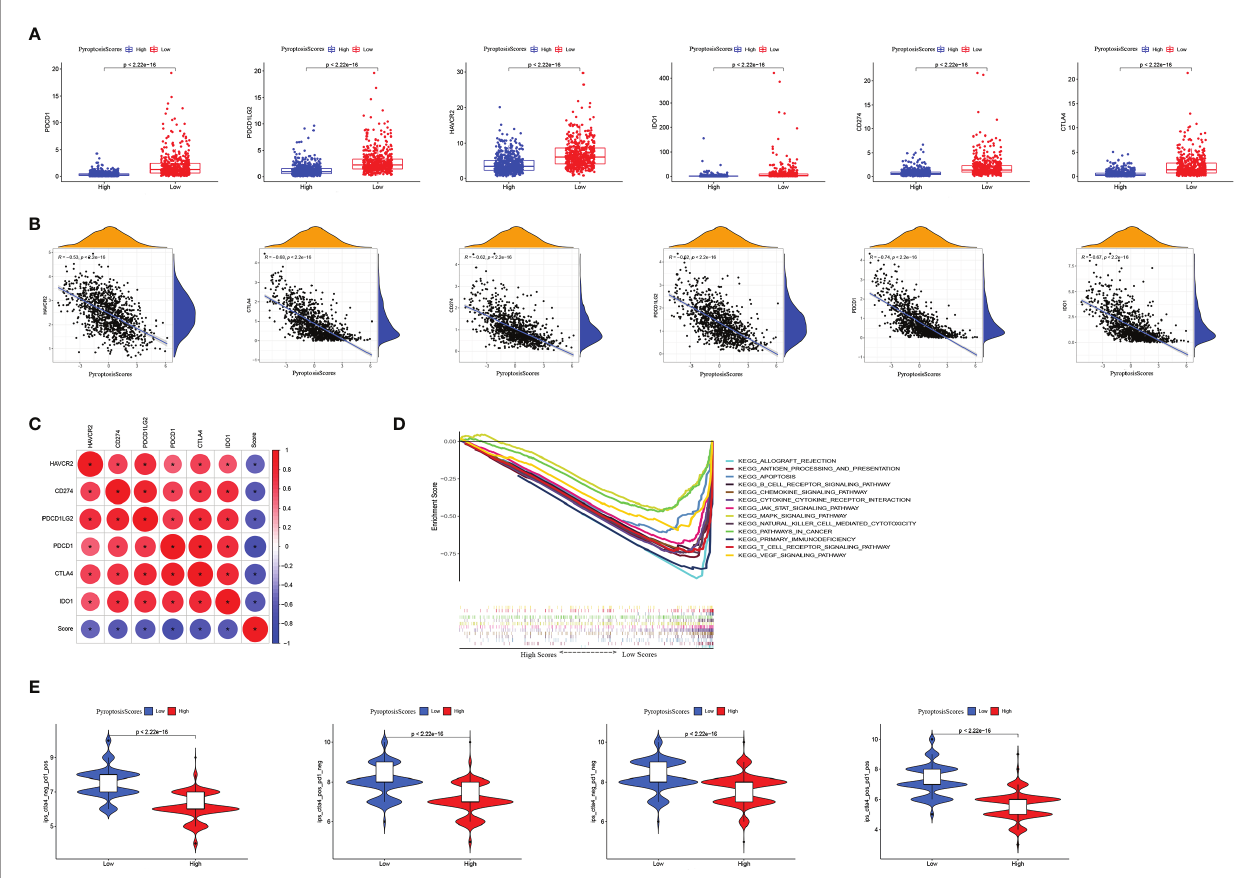
FIGURE 9 | The role of PyroptosisScore in immunotherapy. (A) The expression of immune checkpoints in high and low PyroptosisScore subgroups. (B) Correlation analysis between PyroptosisScore and immune checkpoint. (C) Correlation analysis between immune checkpoints. (D) GSEA enrichment analysis between high and low PyroptosisScore subgroups. (E) Immunotherapy response between high and low PyroptosisScore